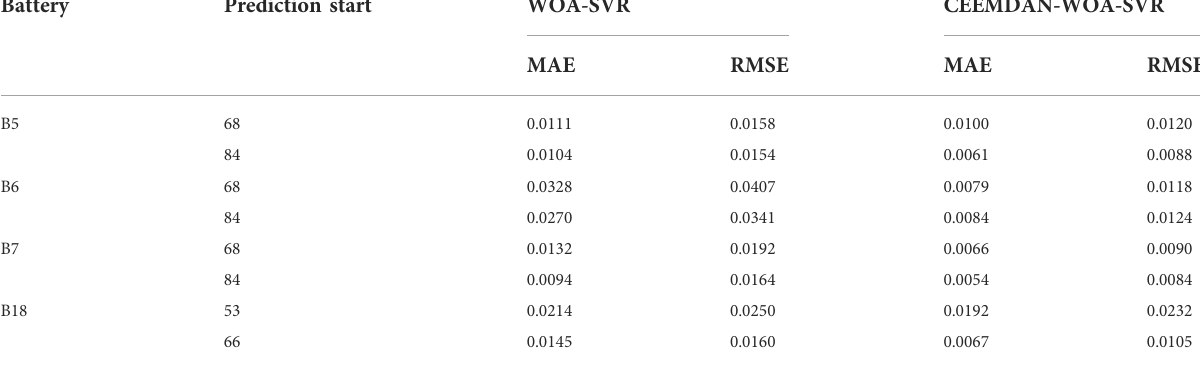
TABLE 3 Results of WOA-SVR and CEEMDAN-WOA-SVR methods for RUL prediction. Battery